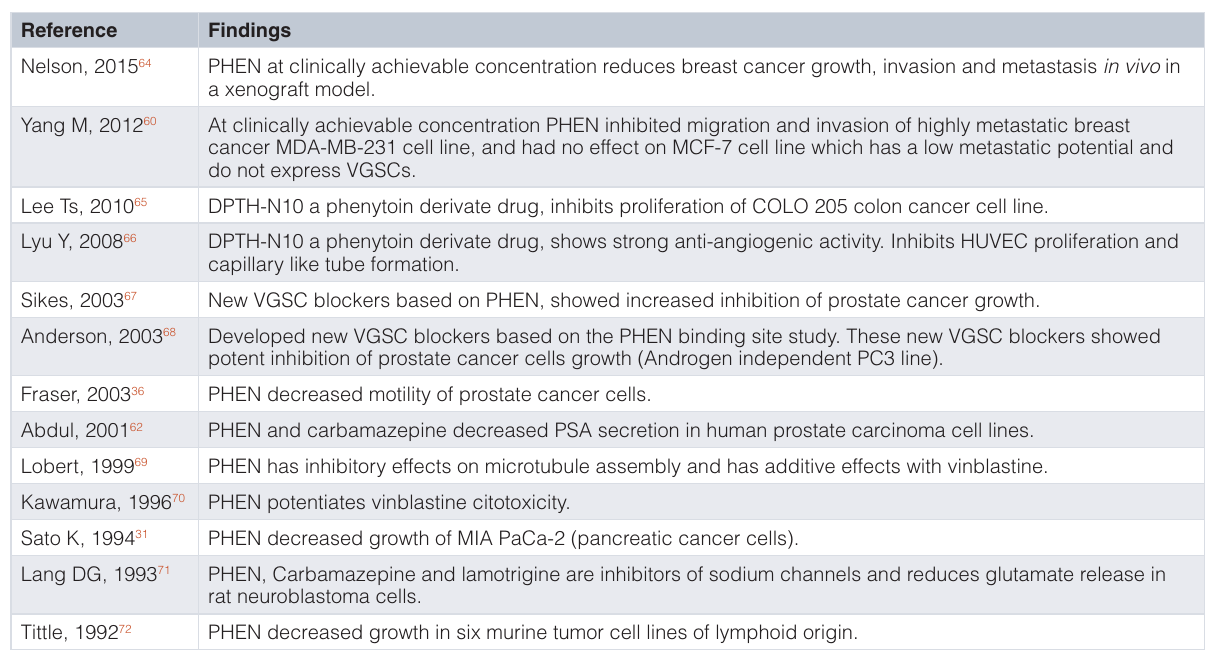
Table 2. Summary of PHEN’s activity against cancer and